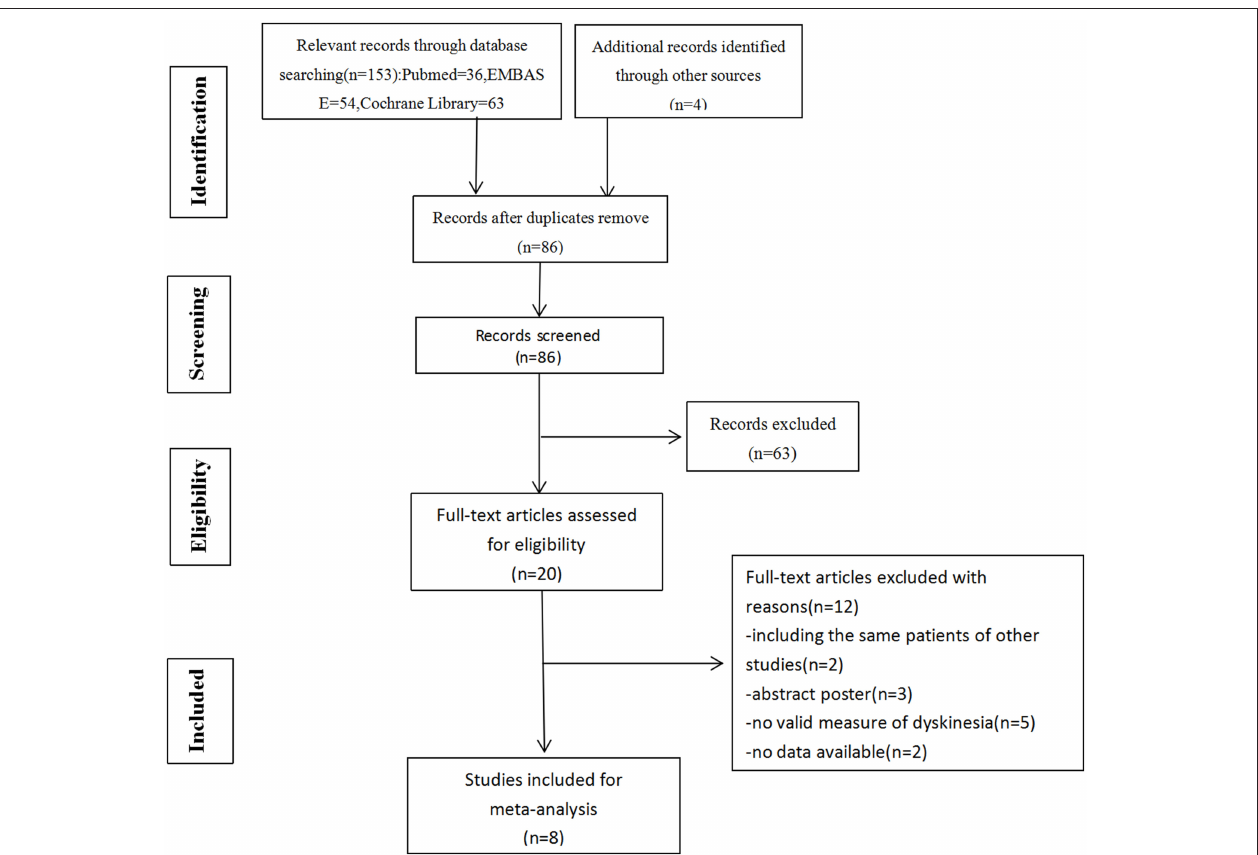
FIGURE 1 | Flow diagram of selection of studies. Among 157 articles screened, 5 randomized controlled studies and 3 non-randomized controlled trials were included in our